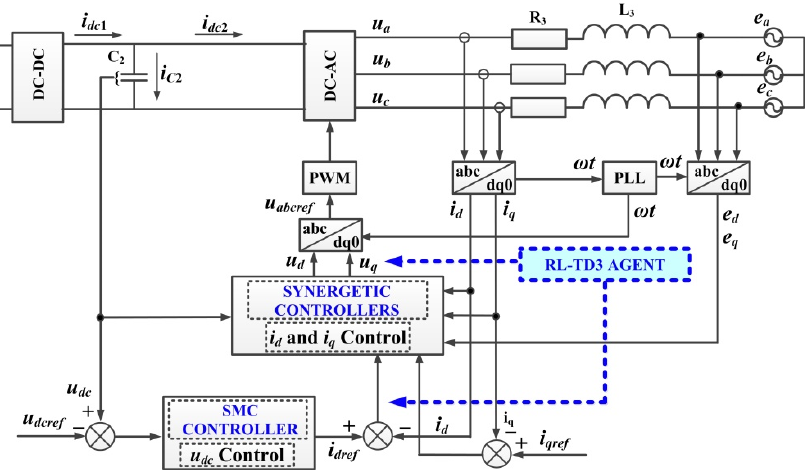
Figure 17. The schematic diagram of the control system for the GC-PV array based on the SMC and